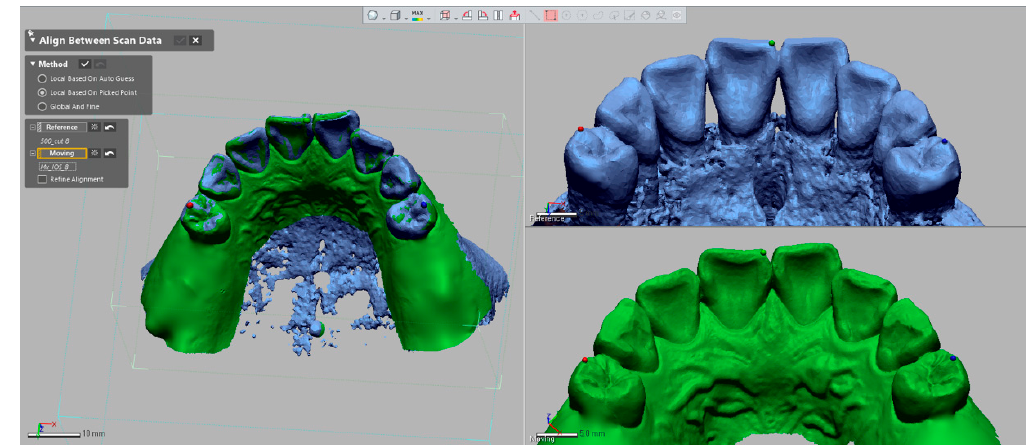
Figure 4. Point-based best-fit image matching between the 3D reconstruction and the optical scan images.